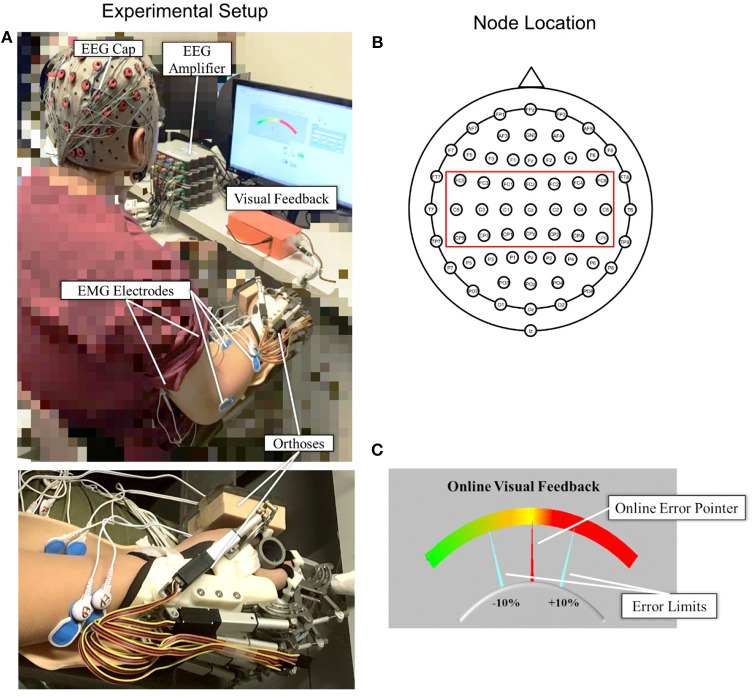
(A) The experimental setup with an enlarged photo of the forearm and hand configuration; (B) top view of the 64-channel g.GAMMAsys cap with 21 channels selected for CMCoh analysis; (C) the interface of visual feedback for real-time contraction level control: The fixed yellow midline is the target contraction level, and the red pointer shows the real-time muscular contraction level.